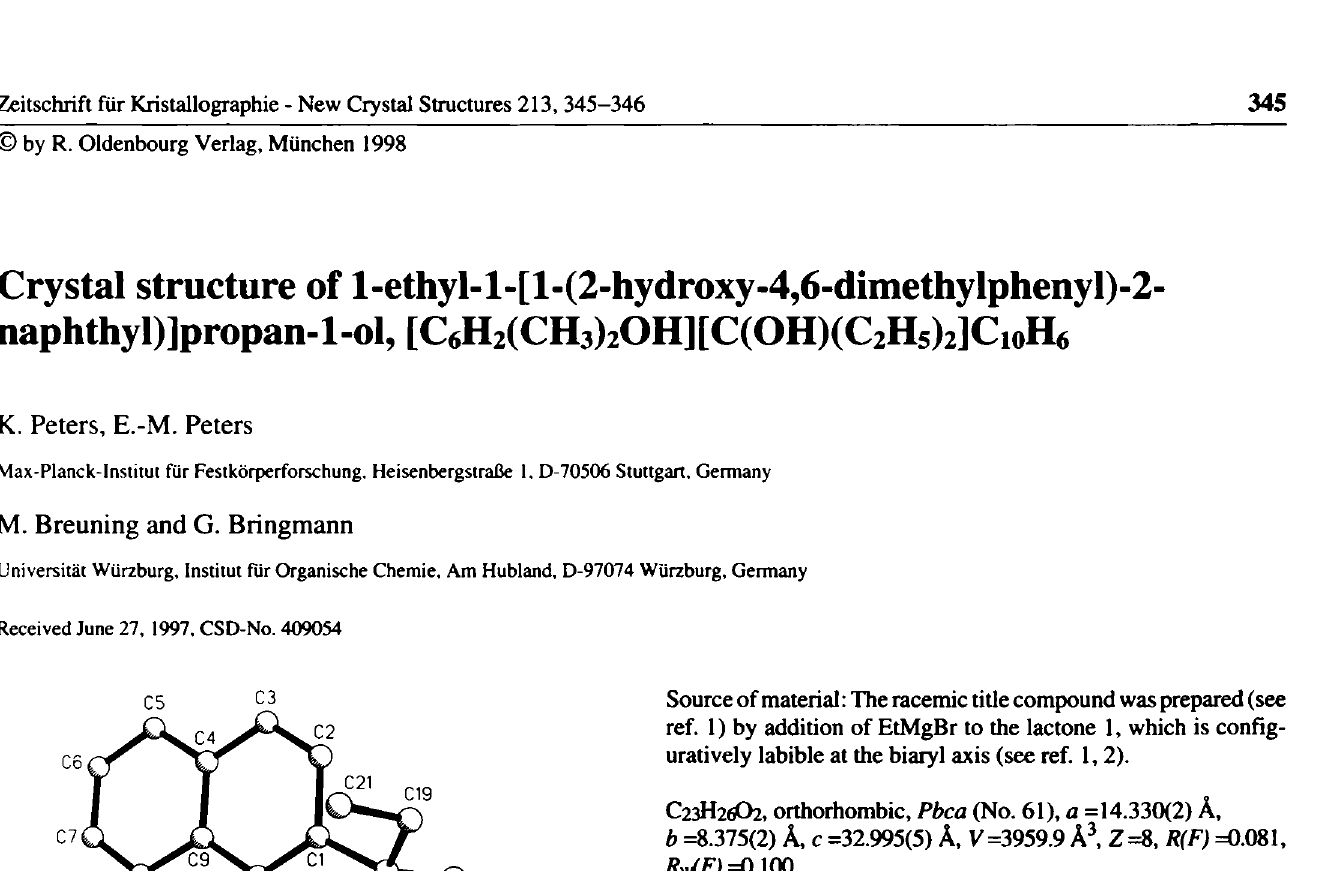
Table 2. Final atomic coordinates and displacement parameters (in Â^)